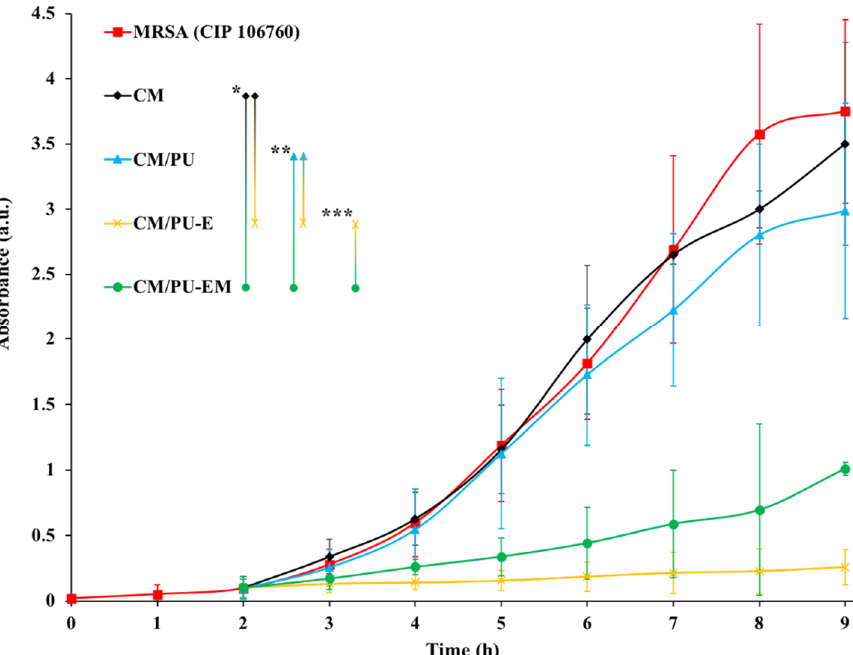
Figure 4. Effects of growth inhibition against the methicillin-resistant S. aureus (MRSA) expressed by the optical density (OD 620 nm ), obtained for uncoated (CM) and coated monolithic filters with pristine polyurethane (PU)-based coating (CM/PU) and containing 2 wt.% of incorporated Econea (CM/PU-E) or grafted Econea (CM/PU-EM). The means ± standard deviations (SDs) for three independent tests are presented. Statistical analysis was performed by the Friedman test and the differences are indicated with ** p < 0.01.